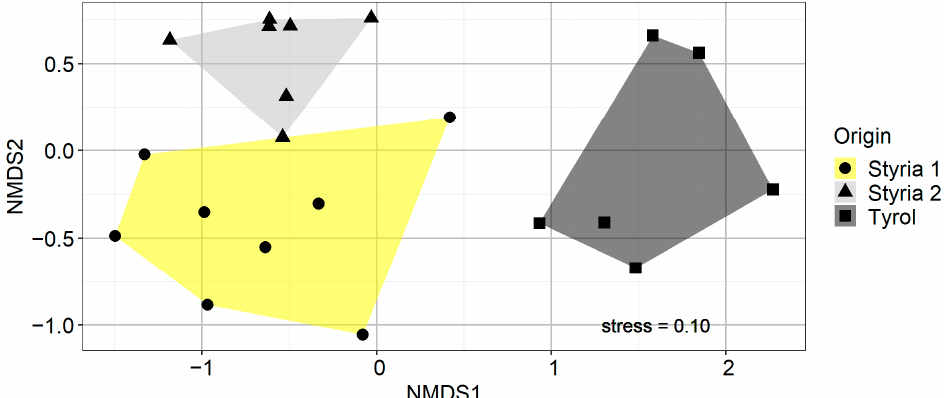
Figure 5. Non-metric multidimensional scaling (NMDS) using abundance of MLGs based on Bray– Curtis dissimilarities showing a different Metarhizium population structure at the treated field sites Styria 1 (circles), Styria 2 (triangle), and Tyrol (square). Each symbol represents the population composition at a sampling time. Data shown is without the applied strain and from samples after the first application of the product. Hulls illustrate the different field sites Styria 1 (yellow), Styria 2 (light grey), and Tyrol (dark grey).